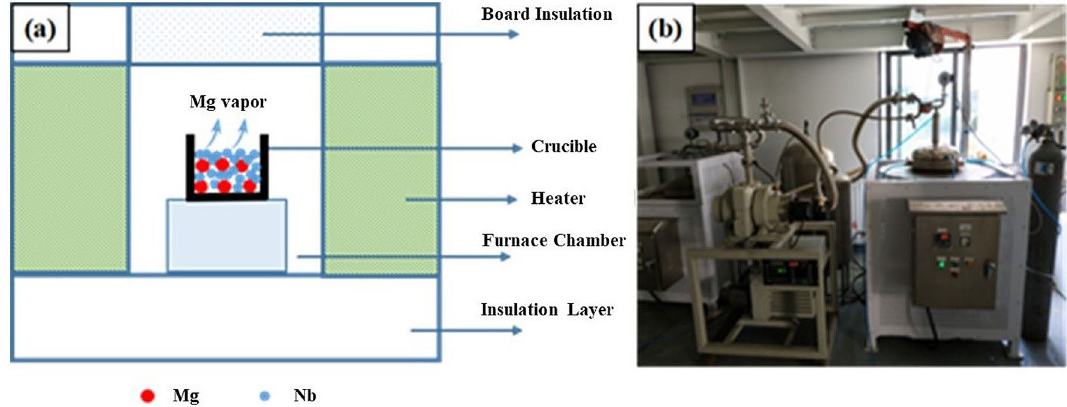
Figure 13. ( a ) Schematic of magnesium deoxidation charging and ( b ) equipment of magnesium deoxidation